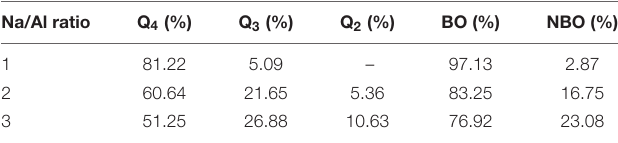
TABLE 4 | Q species, bridging oxygen (BO), and non-bridging oxygen (NBO) of the NASH gel model with different Na/Al ratios. Na/Al